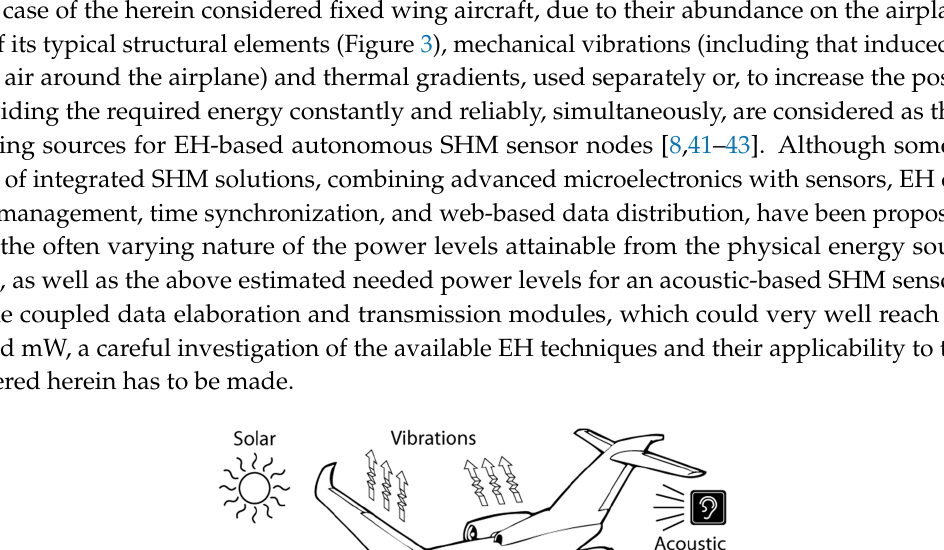
Figure 3. Scheme of an airplane with indicated energy harvesting sources discussed in this work.